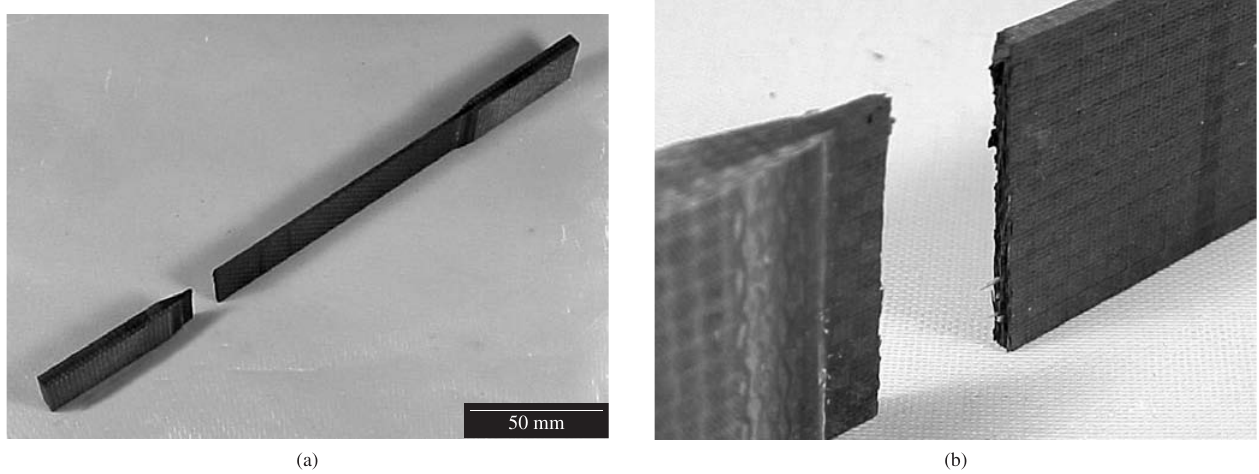
Figure 6. F584/PW laminate: a) specimen tested; and b) detail of the failure mode type LGB ( Lateral Gage Bottom ).